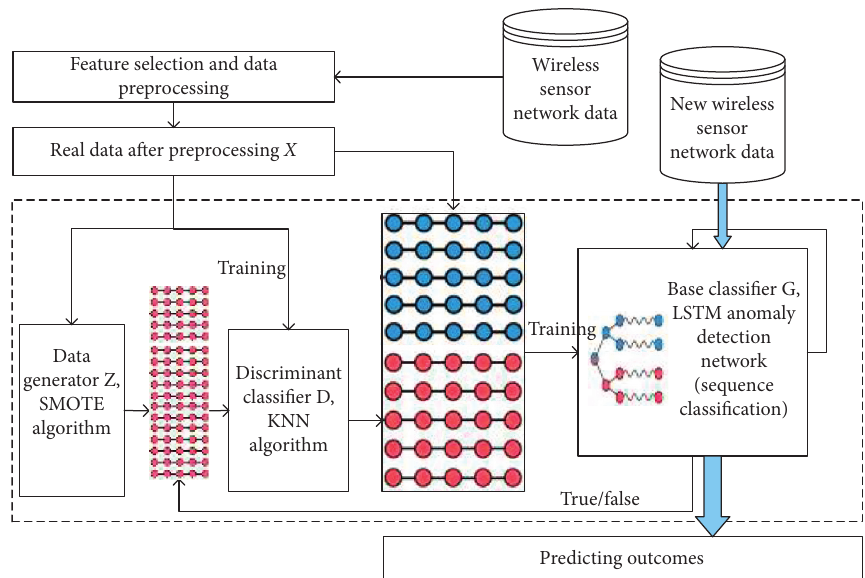
Figure 4: The process of the kNN-SMOTE-LSTM